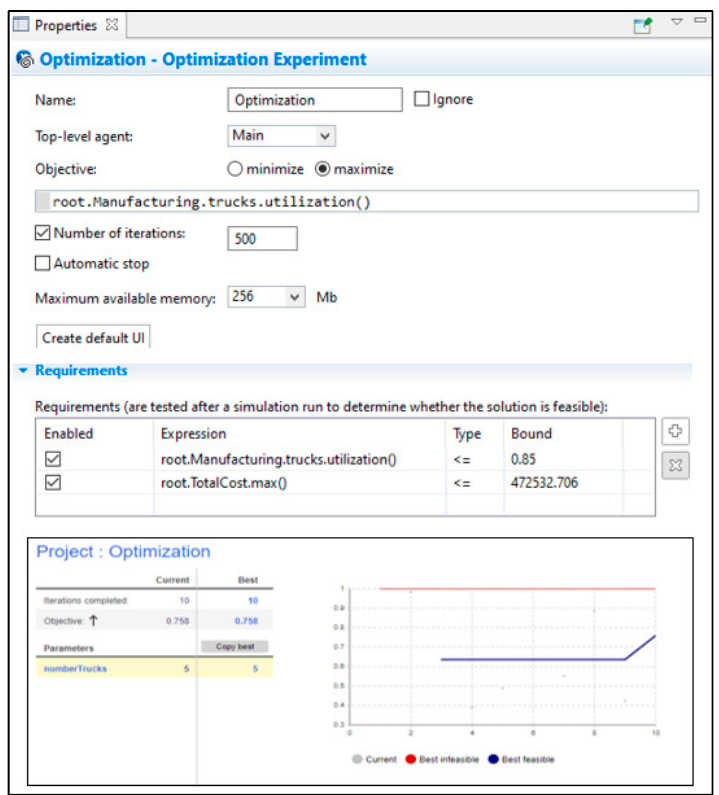
Figure 13. Optimization experiment and its results.